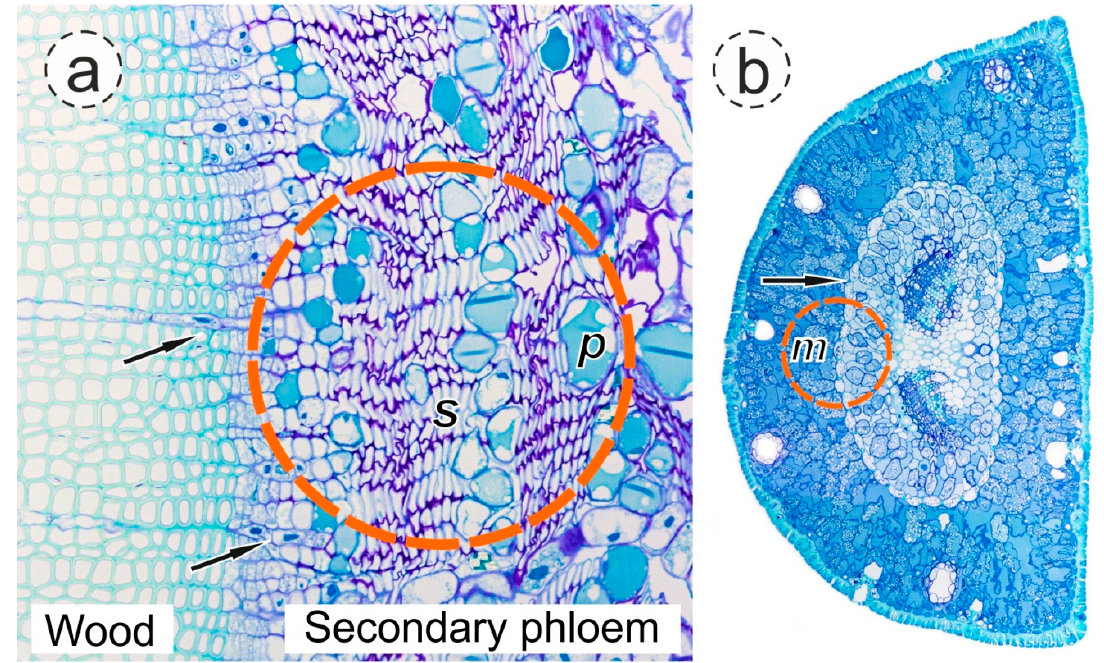
Figure 1. Information on histological anatomical investigations in Pinus mugo ( a ) branches and ( b ) needles. Regions of interest for histological staining are indicated with orange circles, the arrows in ( a ) indicate parenchymatic ray cells, the arrow in ( b ) indicates the endodermis, m, mesophyll; p, parenchyma cell; s, sieve cell.